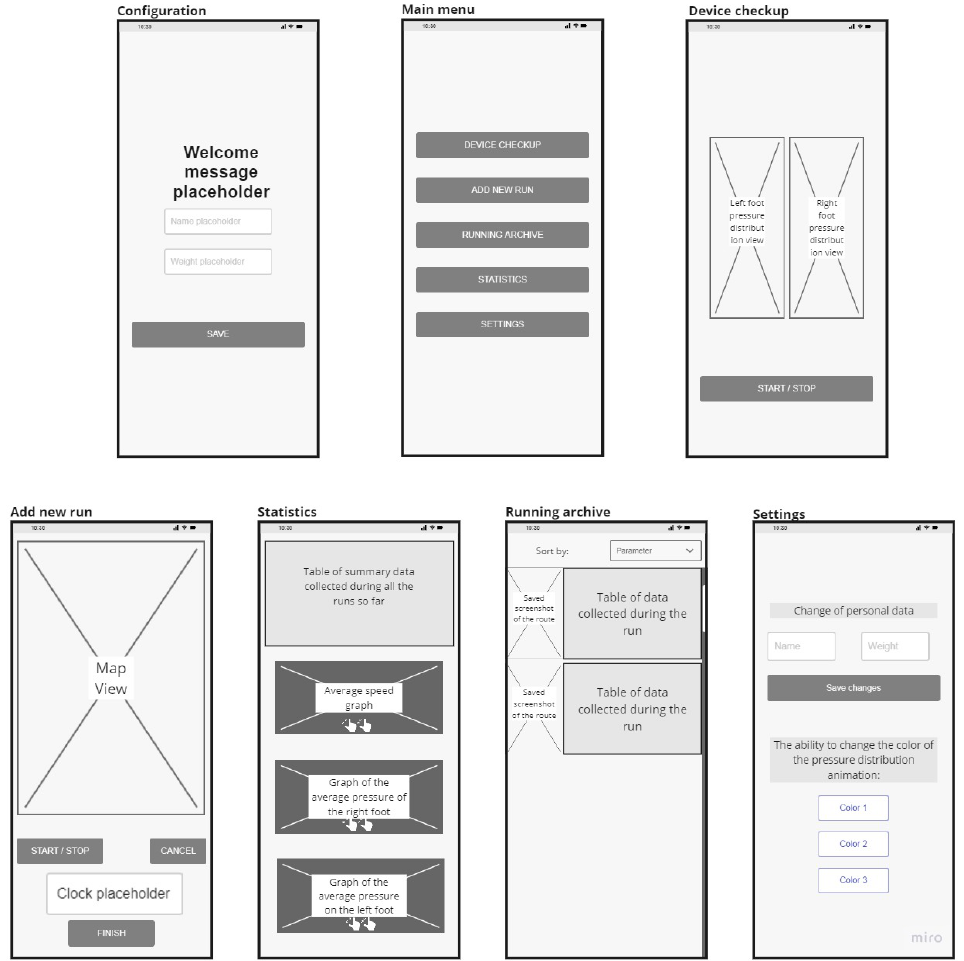
Figure 10. Mobile application screen map (Configuration screen only on the first execution of the app. The Device checkup, Add new run, Statistics, Running archive, and Settings screens are secondary to the Main menu